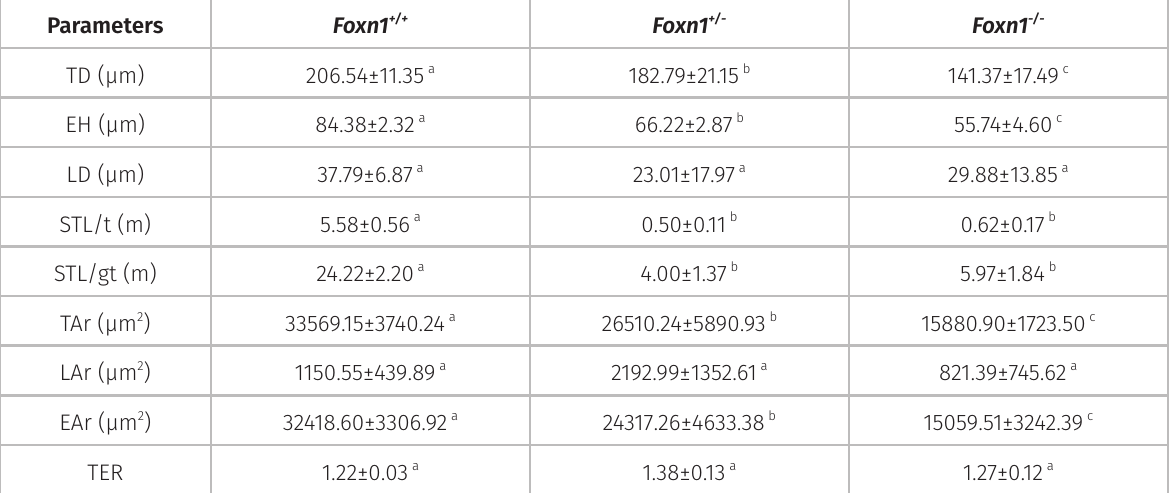
Table II. Seminiferous tubules morphometry and